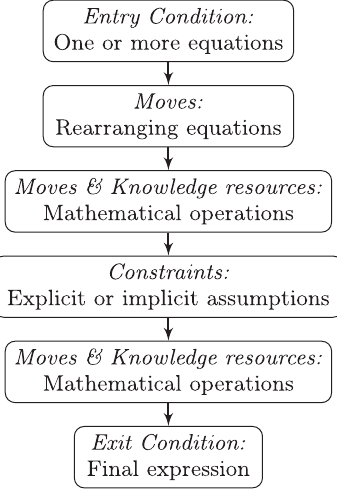
FIG. 4. Components of the analytical derivation epistemic